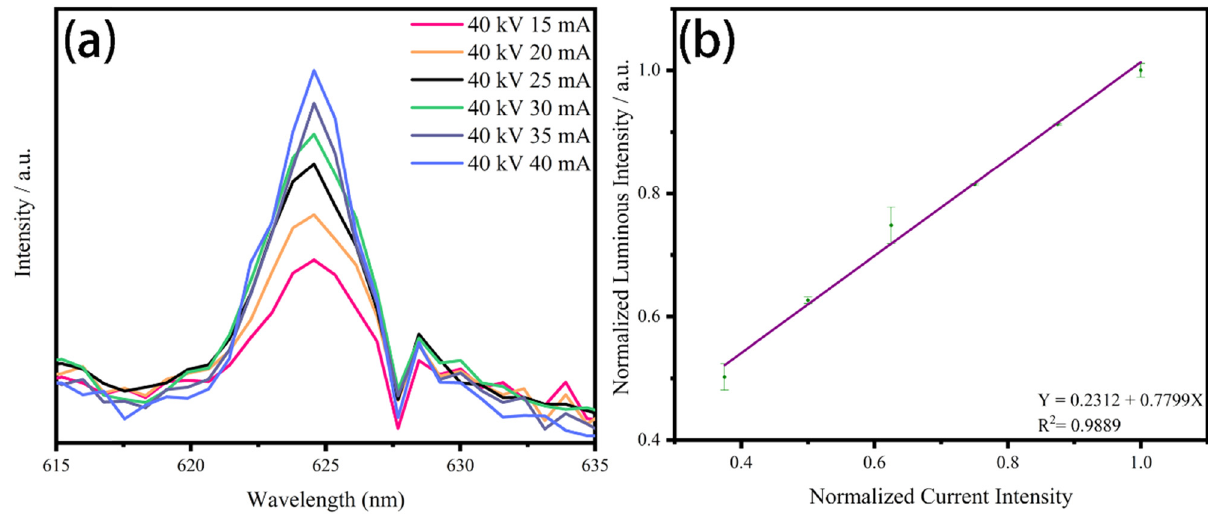
Figure 9: ( a ) The curves of light intensity with di ff erent tube currents and ( b ) the light intensity of the composite gel as a function of varying tube